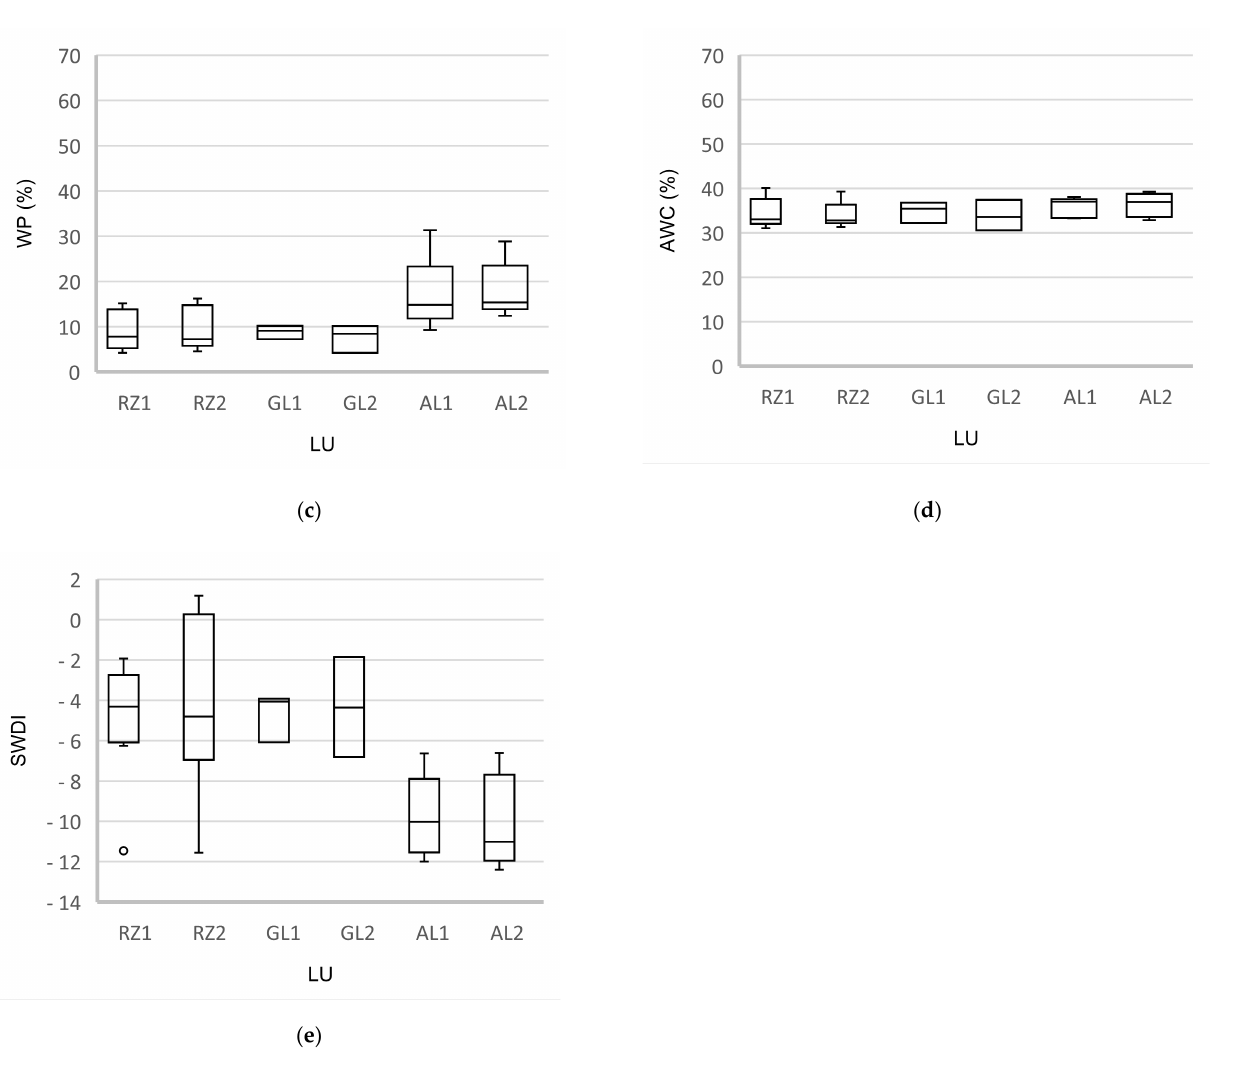
Figure 2. ( a ) Actual soil moisture on September 10, 2018 (SMa); ( b ) Field water capacity (FWC); ( c ) Wilting point (WP); ( d ) Available water capacity (AWC); ( e ) Soil water deficit index (SWDI). RZ—Riparian zone, GL—Grassland, AL—Arable land, 1—Depth 0–10 cm, 2—Depth 20–30 cm.